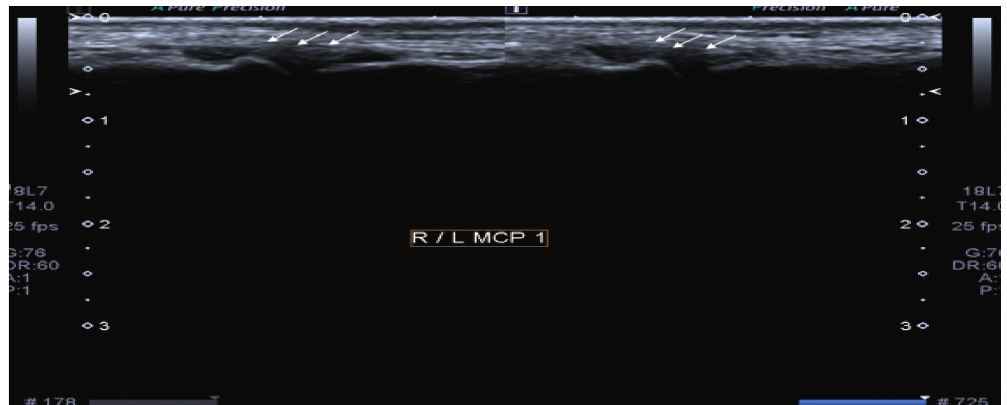
Figure 9: Grayscale images of bilateral 1 st metacarpophalangeal joint demonstrating mild synovial thickening (white arrows). The findings are consistent with Grade 1 synovitis.